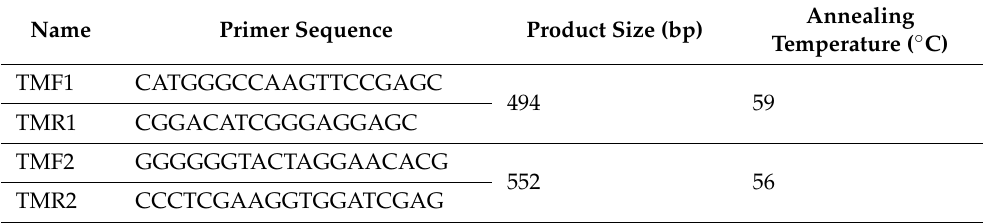
Table 1. PCR primers for the identification of envelope gene (GP41) of